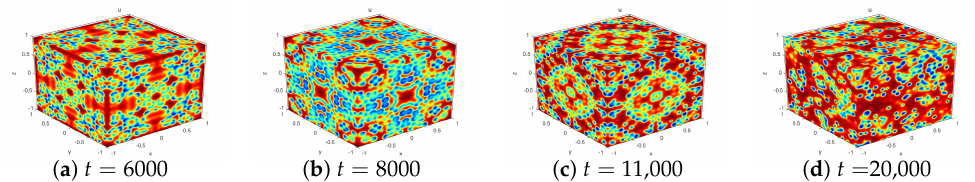
Figure 18. The patterns of u at K u = 2 × 10 − 5 , K v = 1 × 10 − 5 , F = 0.02, k = 0.055, N = 128, and α = β = 1.9 for Experiment